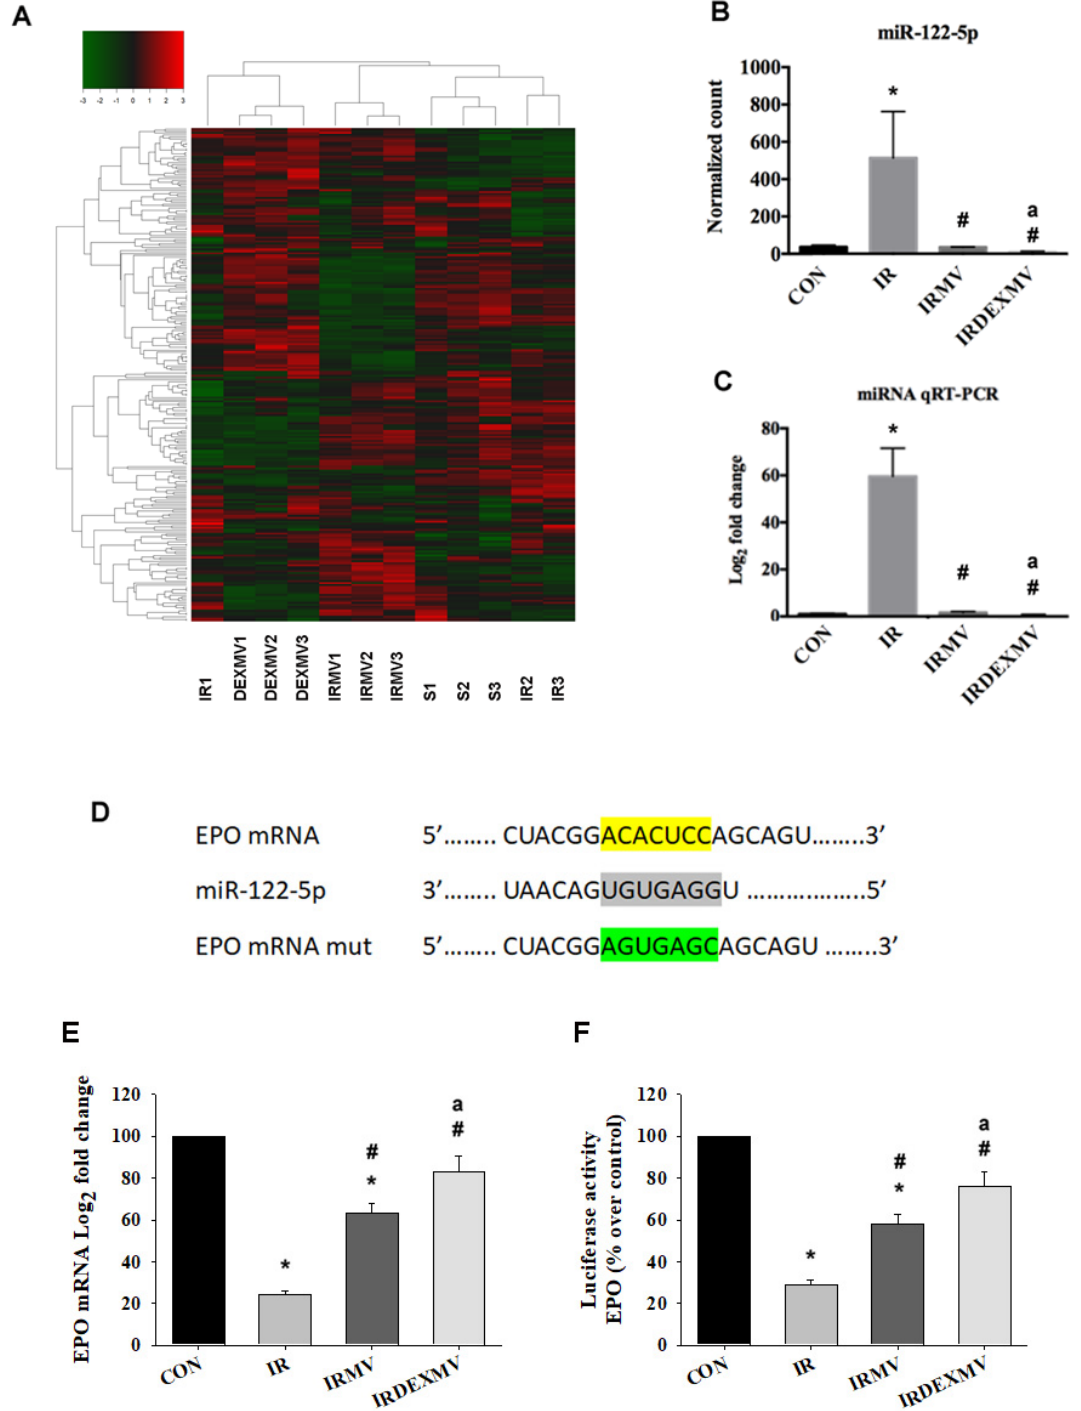
Figure 5. miRNA expression in four groups of kidneys. ( A ) The heat map shows the expression level of whole − kidney miRNAs in CON (S1, S2, S3), IR (IR1, IR2, IR3), IRMV (IRMV1, IRMV2, IRMV3),